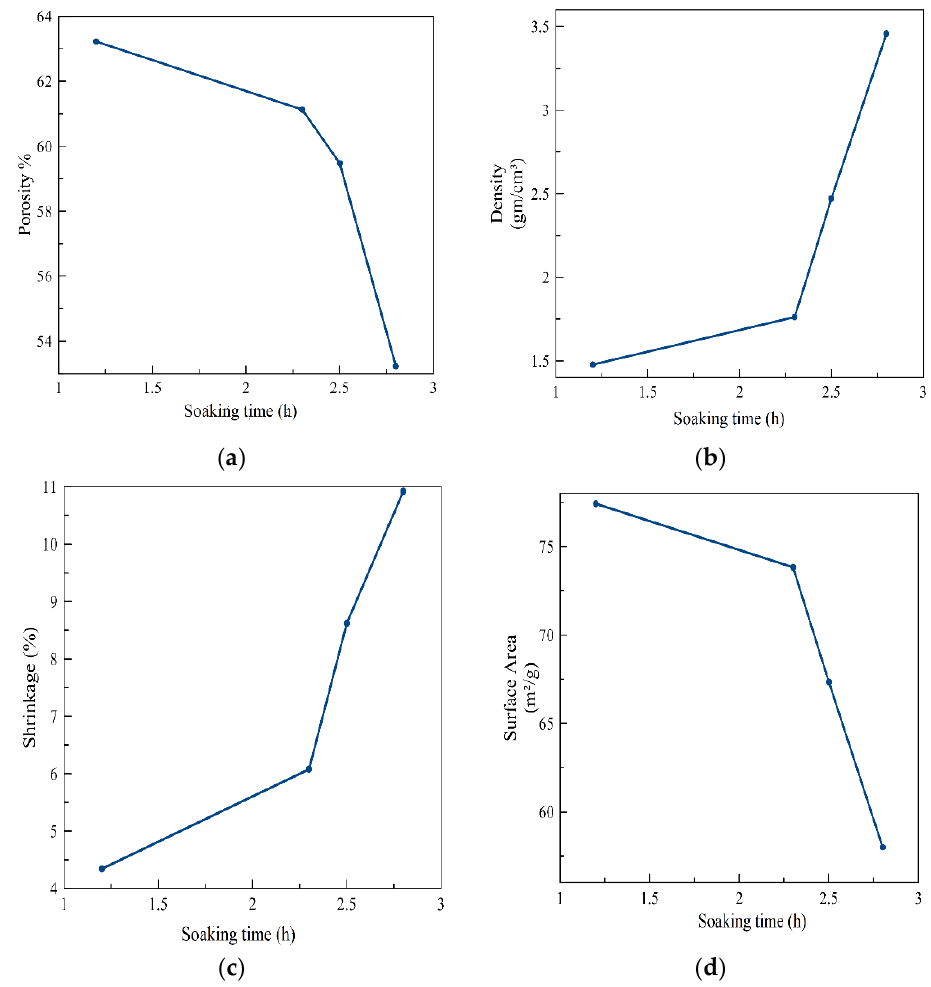
Figure 5. Simulated effect of the soaking time on: ( a ) Porosity, ( b ) density, ( c ) Shrinkage, and ( d ) Surface area.